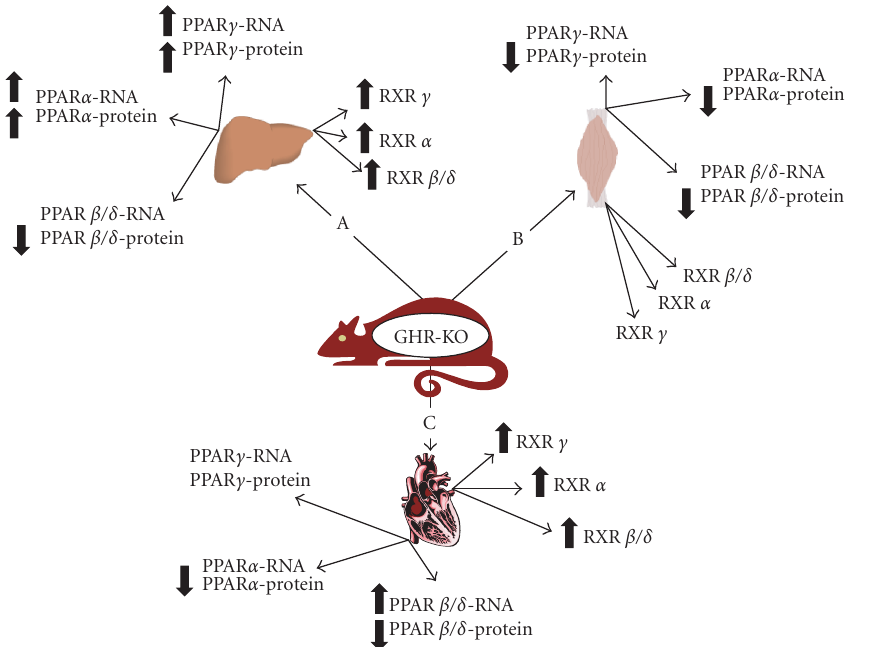
Figure 2: E ff ects of growth hormone receptor/binding protein knockout (GHR-KO) on the expression of PPARs family genes in mouse: (A) liver, (B) skeletal muscle, and (C) heart. Arrows pointing up or down indicate statistically significant increases or decreases ( P < . 05). Lack of arrow means no